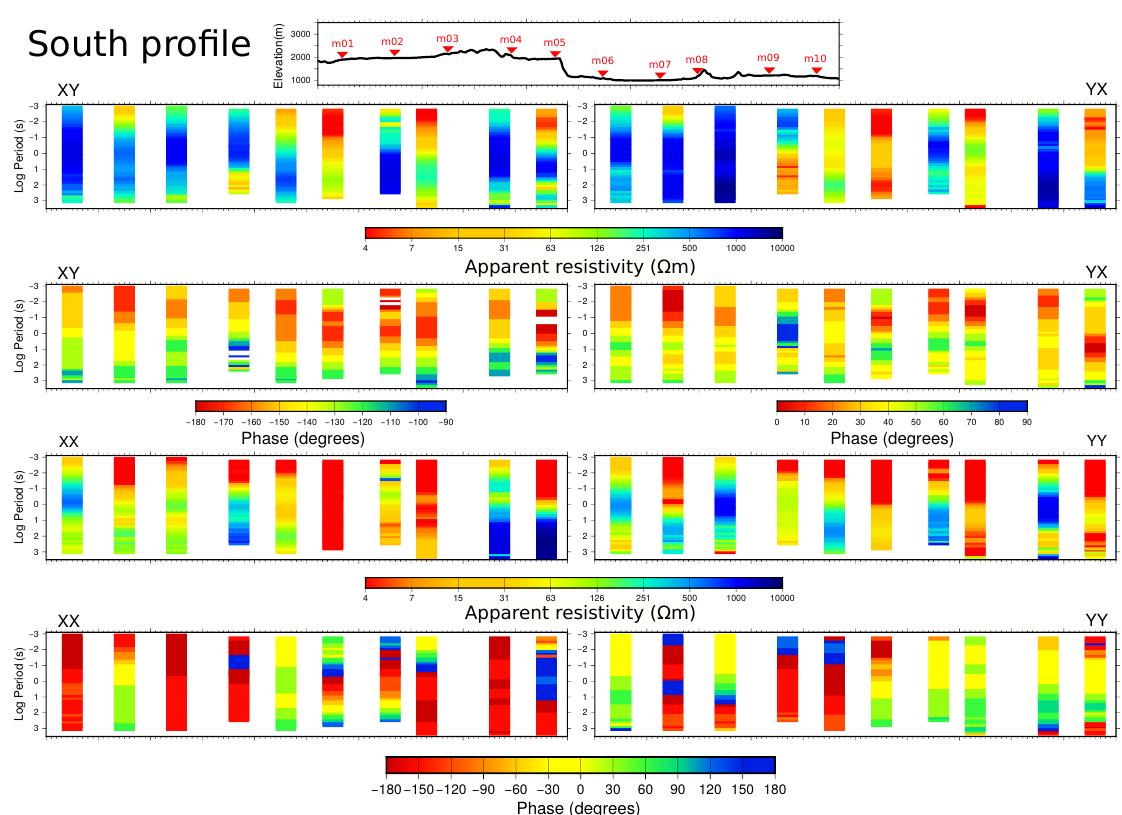
Figure A2. Southern profile (m01–m10): cross sections of apparent resistivity and phase for the four components of the impedance tensor for all